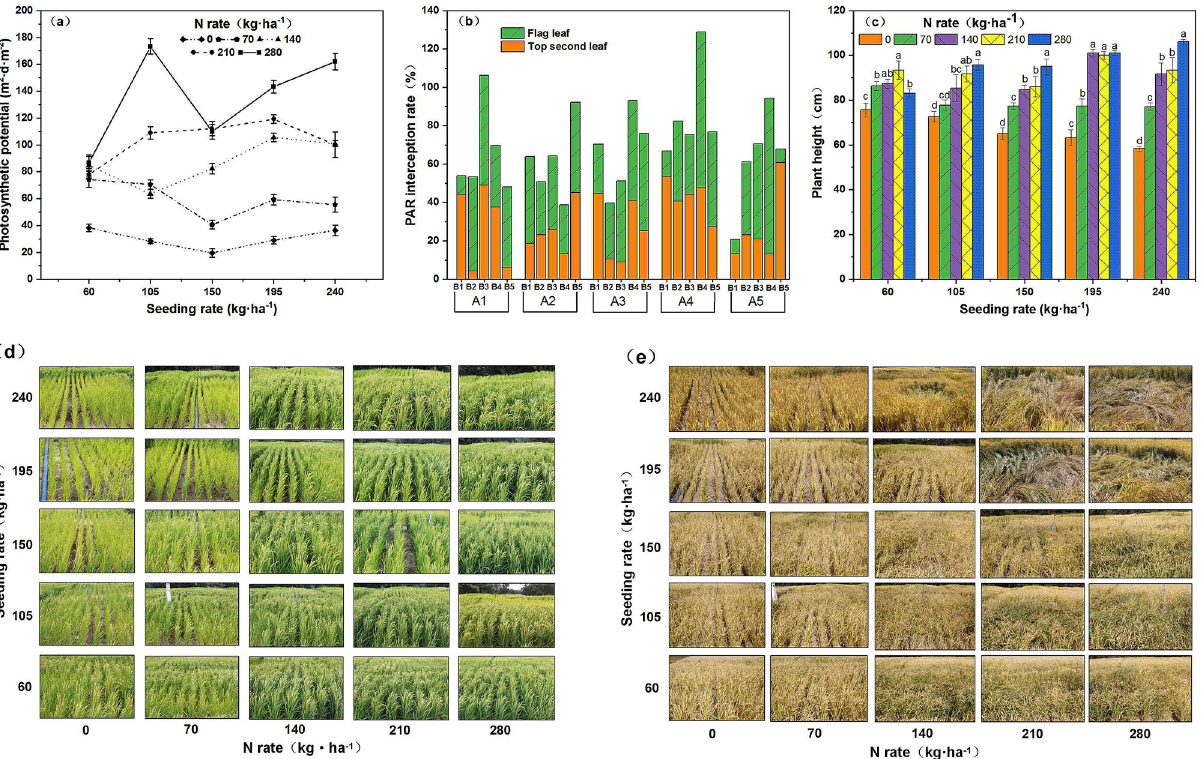
Figure 1. Effects of the interaction between seeding rate and nitrogen rate on the photosynthetic potential of rice, PAR interception rate at different leaf positions, and plant height 10 days after flowering under dry cultivation. ( a ) Photosynthetic potential; ( b ) interception rate of light energy at different leaf positions; ( c ) plant height; ( d ) pictures of plant height using Origin software to process and merge pictures. ( e ) Rice growth after flowering under dry cultivation. ( f ) Growth of rice at the mature stage under dry cultivation. Different letters with the same sowing amount indicate a significant difference at P < 0.05. The figures were prepared and combined using Origin 2018 (www. origi nlab.